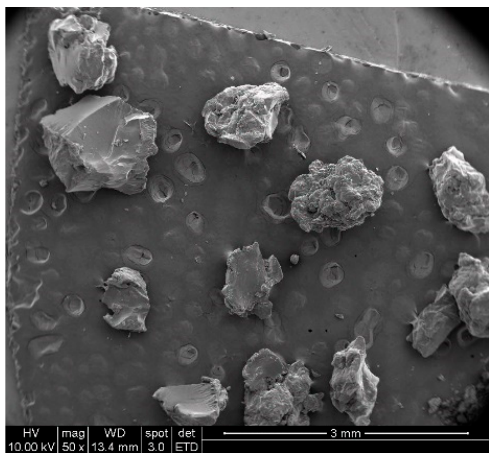
Figure 3. SEM image of SP (50×).